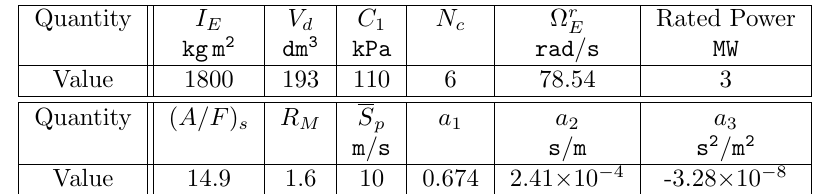
Table 2: The Parameters of the Diesel engine